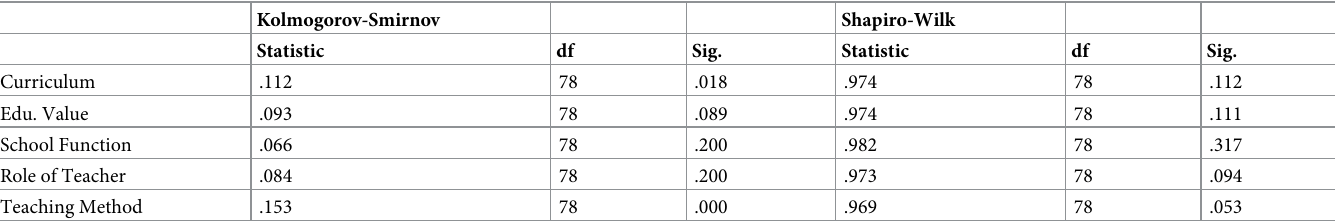
Table 3. Test of normality for the five categories of continuous scale